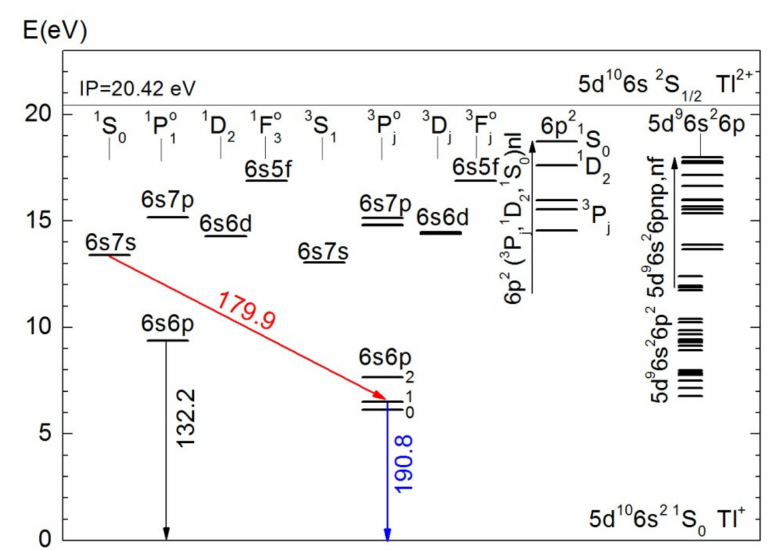
Figure 3. Energy level diagram of the Tl + ion and Tl